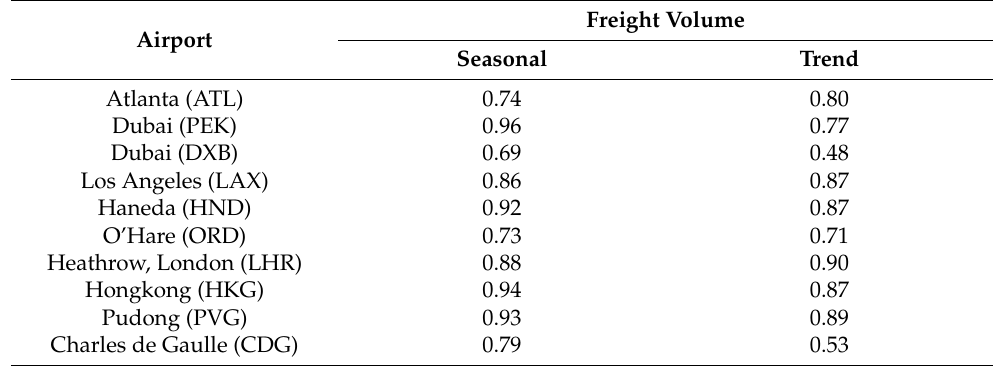
Table 2. Seasonality and trend strength of three major categories of air freight traffic at the top ten